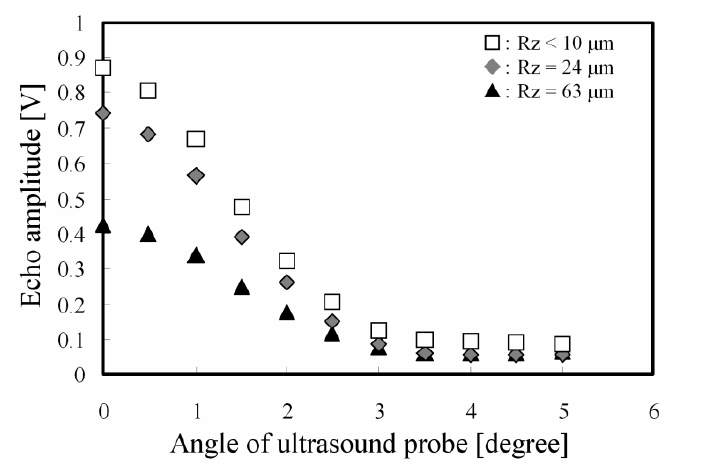
Figure 4: Relationship between echo amplitude and probe angle. The acrylic plates (Rz < 10 µ m, Rz = 24 µ m, 63 µ m) were used as reflection